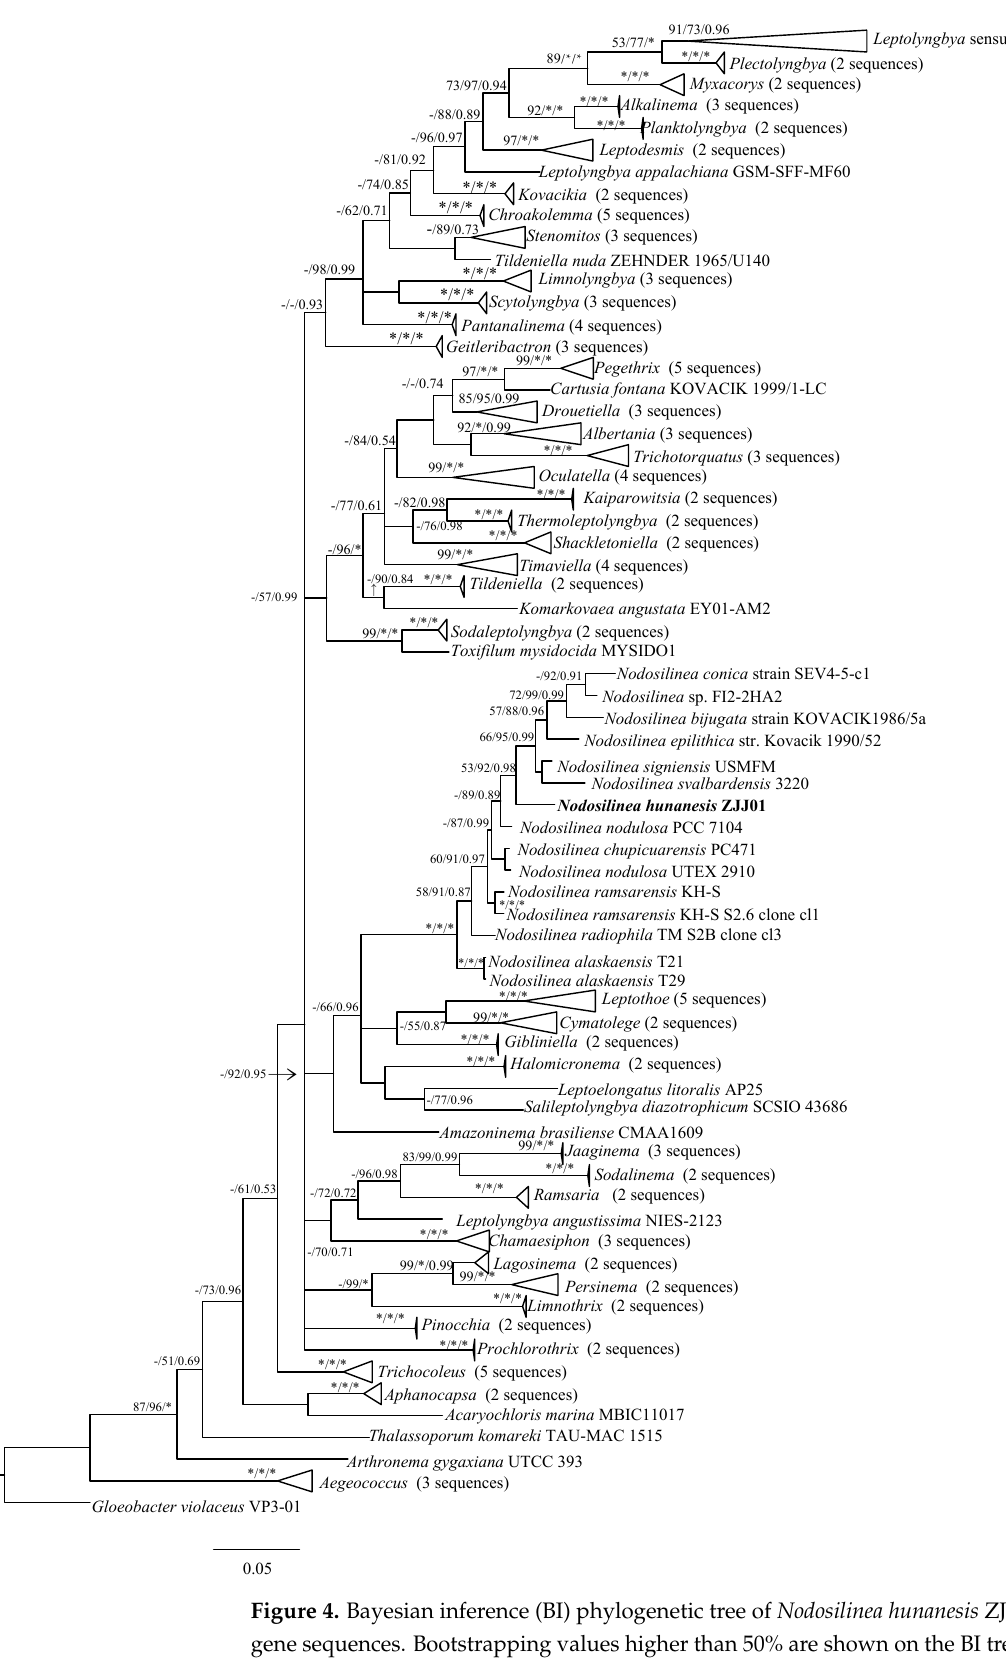
Figure 4. Bayesian inference (BI) phylogenetic tree of Nodosilinea hunanesis ZJJ01 based on 16S rRNA gene sequences. Bootstrapping values higher than 50% are shown on the BI tree for MP/ML methods and Bayesian posterior probabilities. * indicates bootstrapping values of 100 in MP, ML, and BI posterior probabilities of 1.00. The novel filamentous strain of this study is indicated in